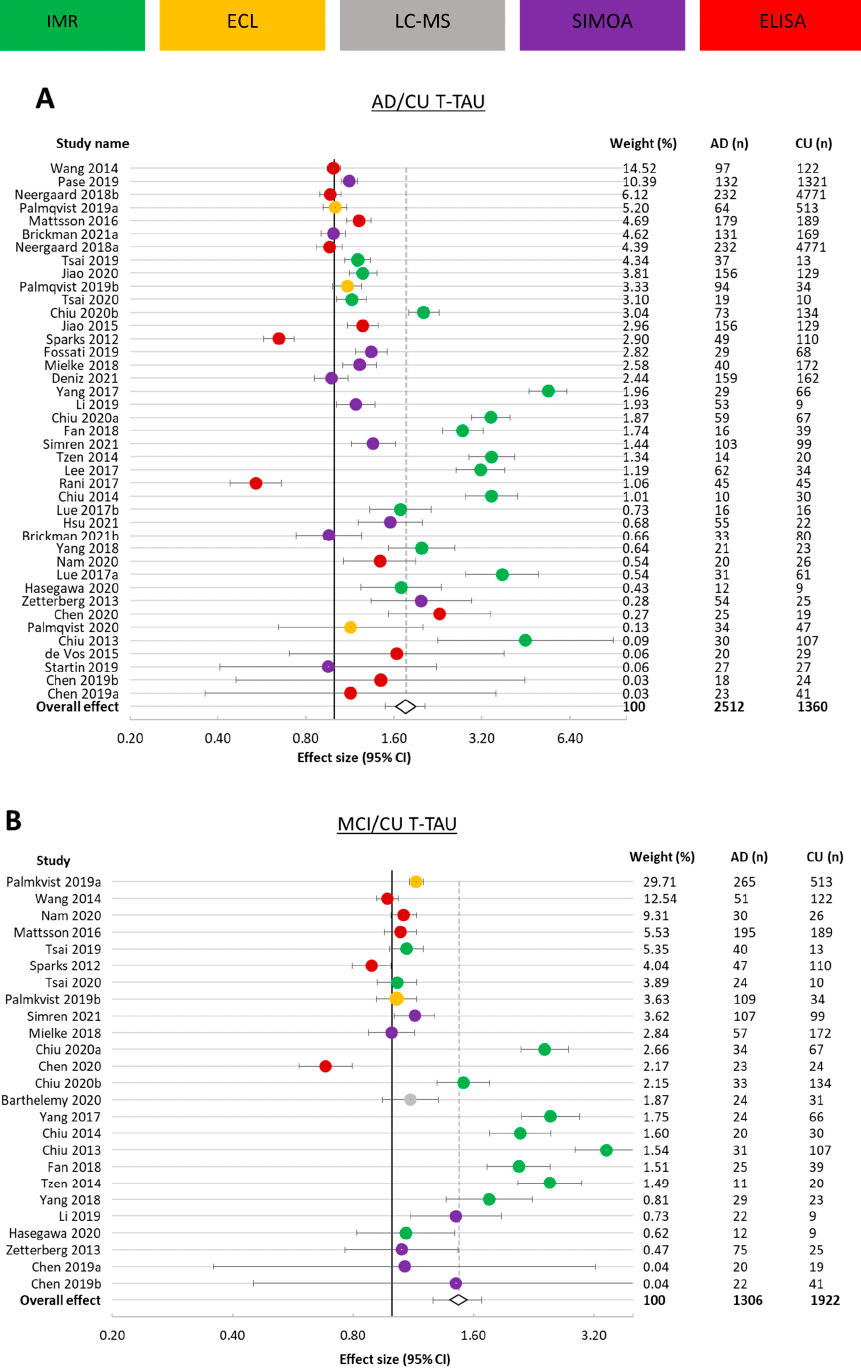
Figure 3. Forest plot for studies presenting plasma/serum t-tau. ( A ). Alzheimer’s disease (AD) versus cognitively unimpaired (CU) participants. ( B ). Mild cognitive impairment (MCI) versus cognitively unimpaired (CU) participants. Ratio (effect size) and 95% CI for individual studies are presented by a circle, color-coded by assay type, and the overall ratio is presented by a diamond and a grey vertical line. Studies are arranged in descending weight order. Data are presented on a log scale. An effect size of 1 indicates equal biomarker concentrations in AD and CU. Percentage weight, number of AD participants, and number of CU participants are displayed on the right side of the forest plot for each study and the combination of all studies. AD: Alzheimer’s disease; CU: cognitively unimpaired; CI: confidence